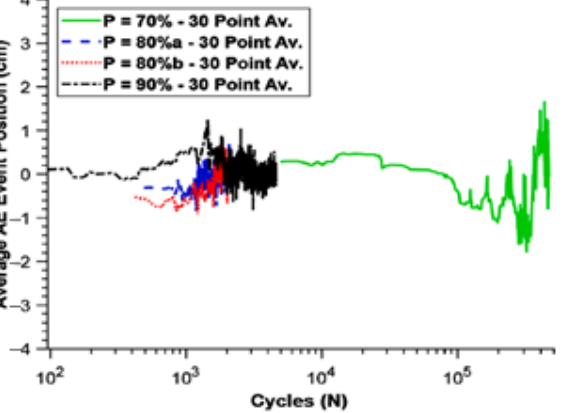
Figure 9. Acoustic Emission event location data covering different load percentages [9].